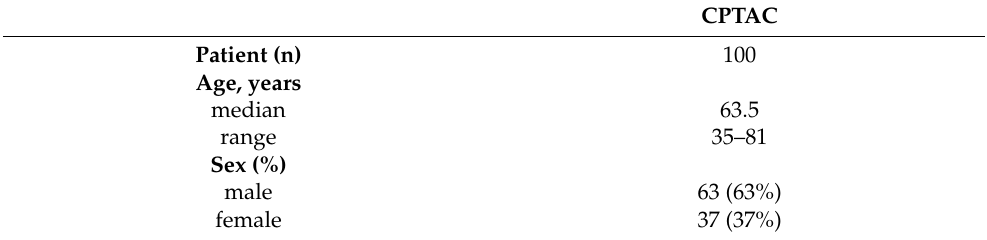
Table 1. The pathological characteristics of the lung adenocarcinoma